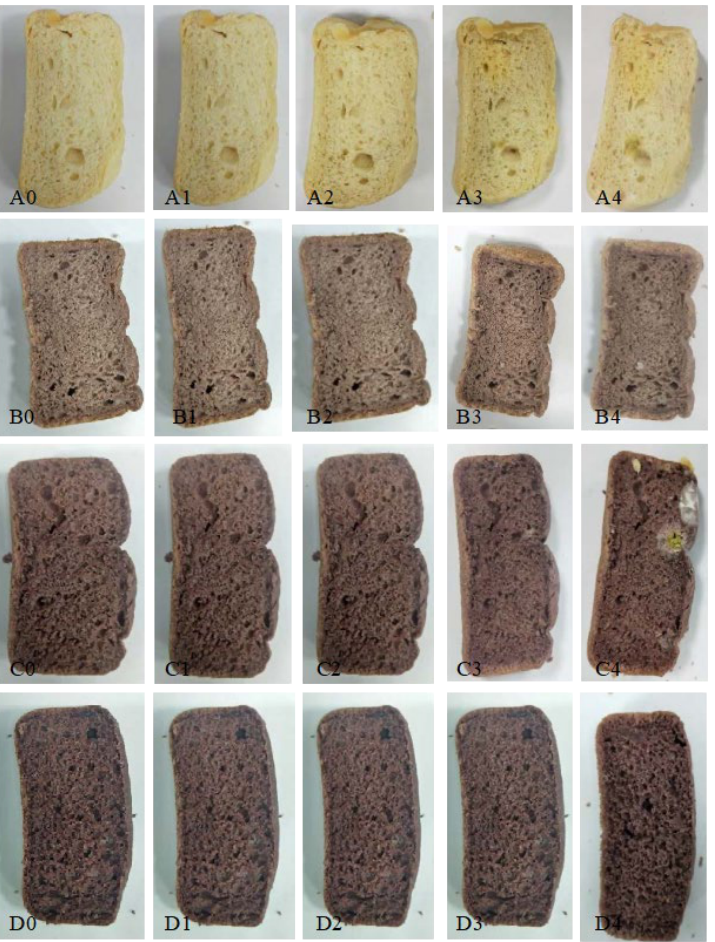
Figure 4. Mold growth of different black rice sourdough powder proportions of black rice sourdough bread. Codes A, B, C, and D represent BB0, BB10, BB20, and BB30 groups, respectively, and codes 0, 1, 2, 3, and 4 represent storage days 0, 1, 2, 3, and 4, respectively.